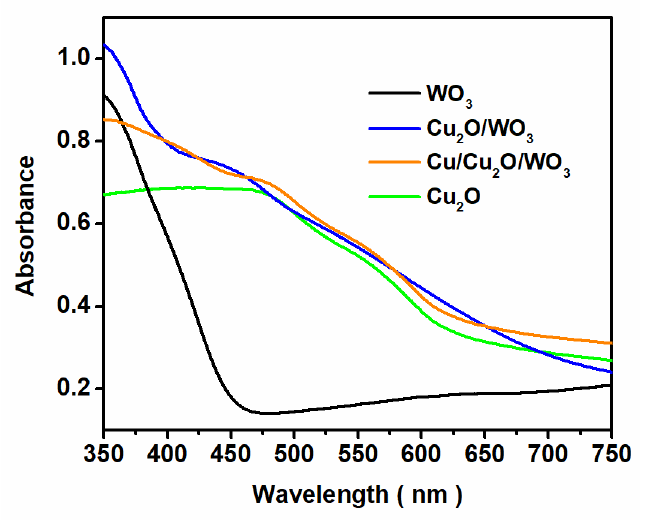
Figure 5. UV-Vis diffuse reflectance spectra of WO 3 , Cu 2 O, Cu 2 O/WO 3 and Cu/Cu 2 O/WO 3 compo- sites.